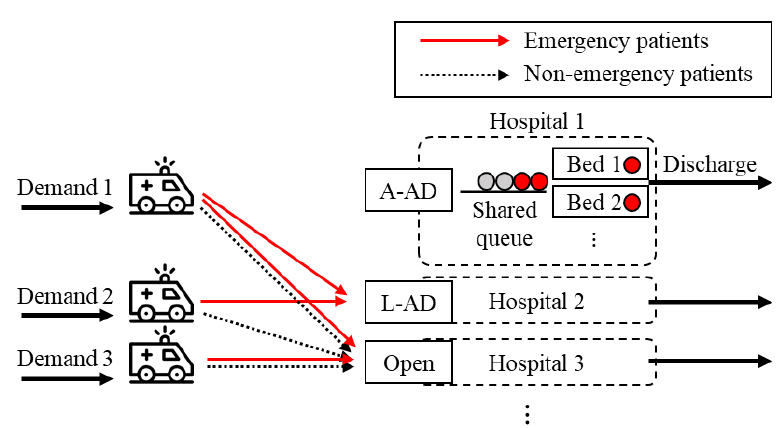
Figure 1. Ambulance-transported patient flow depending on the type of ambulance diversion (AD) decisions. L-AD, low-severity AD; A-AD, all AD.